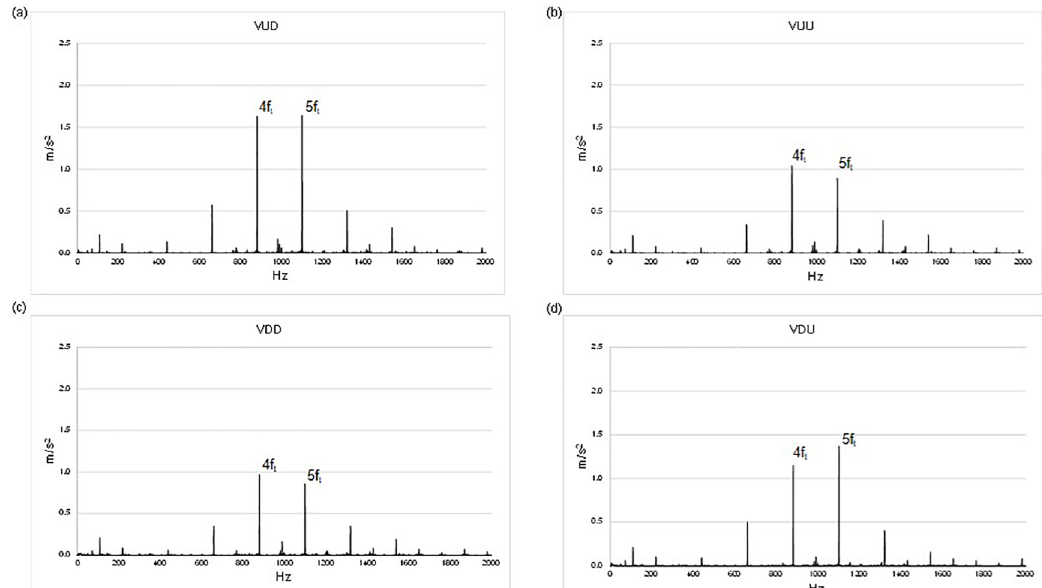
Figure 8. Spectrum of the acceleration signals for vertical tool path orientations at inclined workpiece angle of 75º (a) VUD, (b) VUU, (c) VDD, (d) VDU